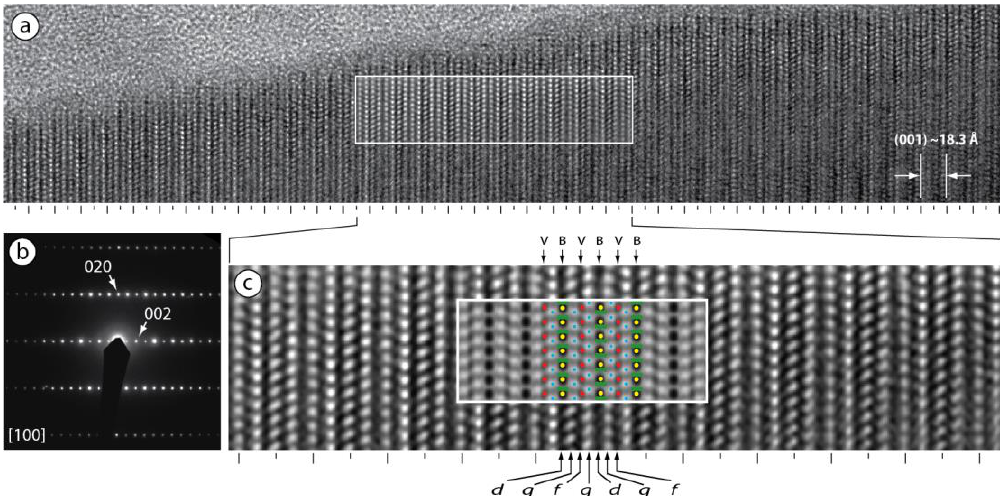
Figure 8. Synchysite-(Ce) from Cinquevalli (Trento, Italy): ( a ) [100] HRTEM image showing a zig-zag contrast of perfectly ordered sequence of synchysite half-cells (~9.1 Å). Every two of them originate the (001) lattice repeat of ~18.3 Å. ( b ) Related SAED pattern. Consistently with the HR image, it is free of streaks. 00 l reflections with l (cid:44) 2 n should be absent by symmetry but are indeed present because of dynamical effects. ( c ) Enlarged filtered portion of ( a ) compared with a calculated image (inset; simulation parameters are: defocus = 43 nm; thickness = 1 nm, atomic vibration = 0.05 nm). Atomic positions are indicated by dots: red = Ca; yellow = Ce; green = F; blue = average position of C atoms). Note how Ca-layers ( f ) and CeF-layers ( d ) form dark fringes that are separated by rows of white dots, corresponding to C-layers ( g ). Corresponding vaterite-like ( V ) and bastnäsite-like ( B ) layers are also indicated. Under optimal experimental conditions, Ce-layers form thicker fringes than Ca-layers; moreover, the average positions of white dots related to carbon atoms is offset along b* across the Ca-layers, whereas no shift is seen across the CeF-layers.